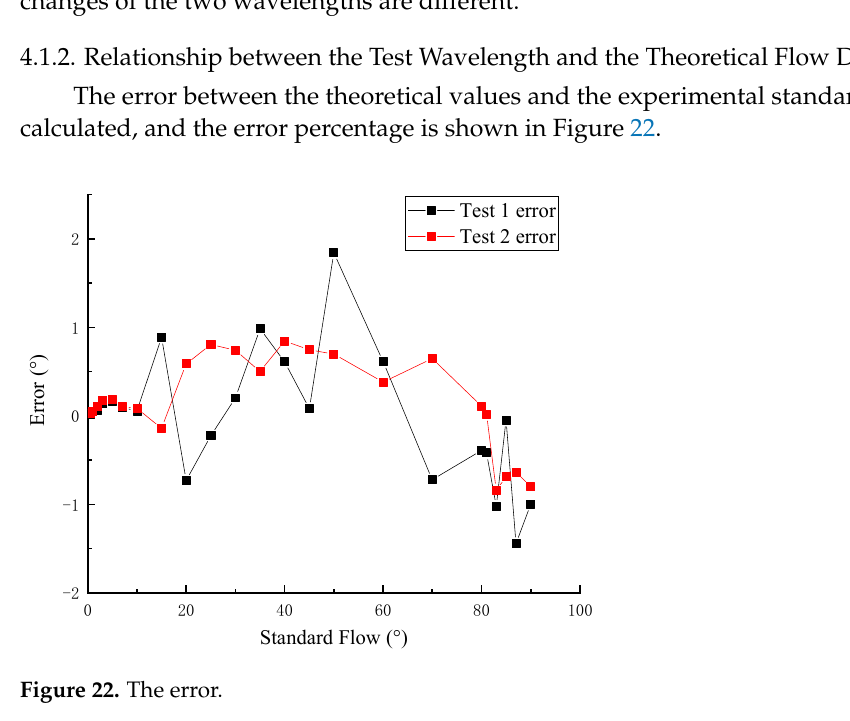
Figure 23. Analysis of the experimental frequency and the theoretical frequency.